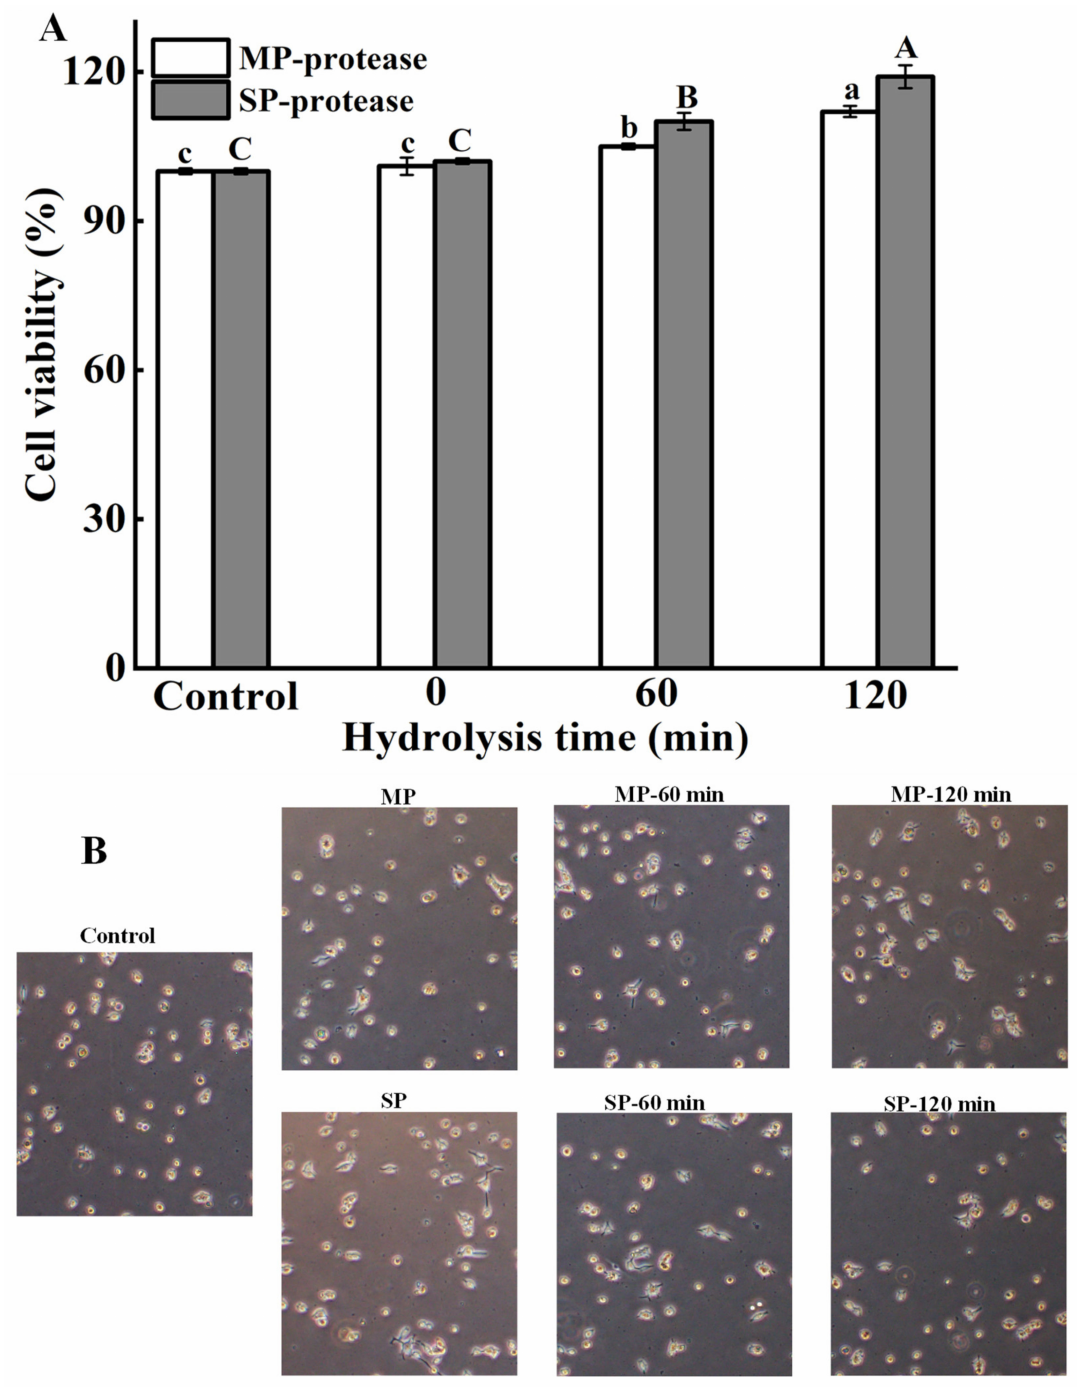
Figure 7. ( A ) Cytotoxicity assay of HEK-293 cells treated with MP and SP. ( B ) Morphology of HEK- 293 cells treated with MP and SP. Different letters in the same column represent significant differences in different samples ( p <